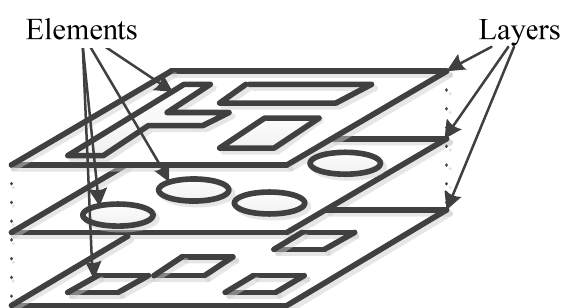
Fig. 2. Map layer composition